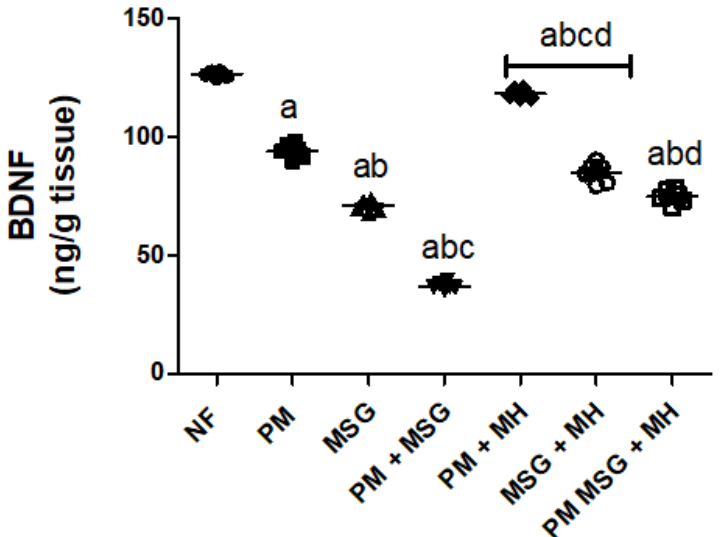
Figure 8. MH adjust BDNF content of PM and/or MSG—fed rat pups. Effect of 60 mg/kg MH on brain BDNF content of PM diet and/or 0.4 g/kg MSG. Data presented as mean ± SEM ( n = 6). a–d